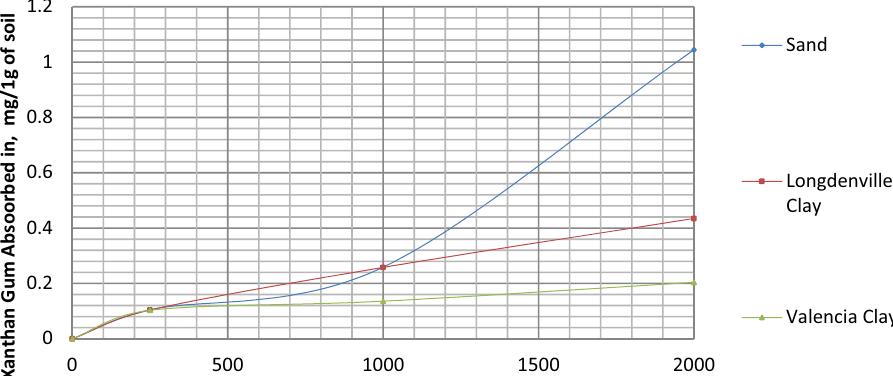
Fig. 7 Xanthan gum polymer adsorption on sand, Valencia clay and Longdenville